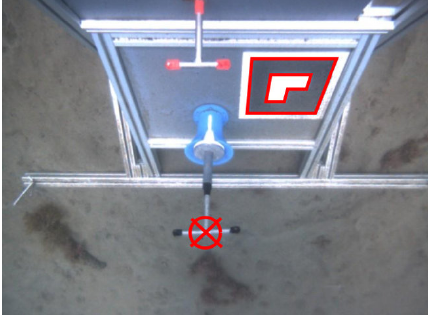
Figure 5. The ART marker is detected for an estimation of the position of the hot stab